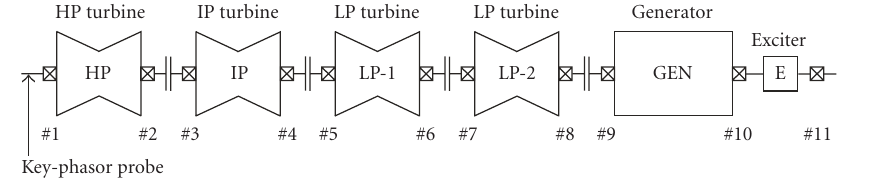
Figure 1: Machine train diagram.